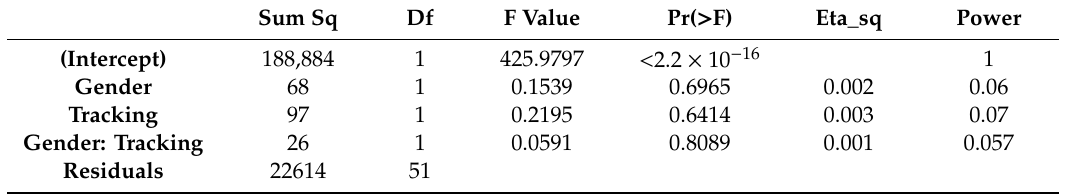
Table 4. Type III 2-way unbalanced design ANOVA for individual average heart rate.